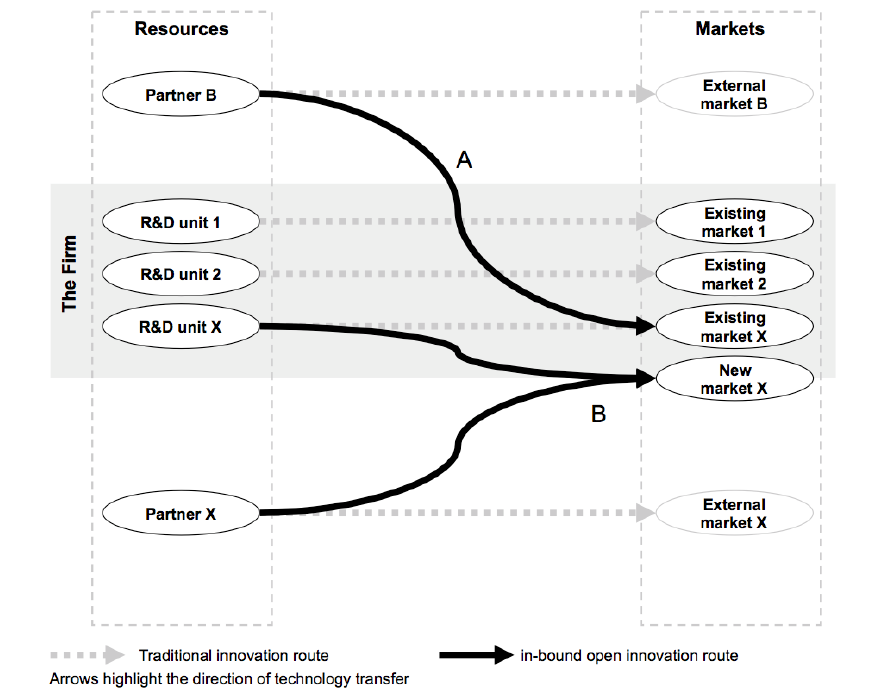
Fig. 2. In-bound open innovation (Mortara et al., 2011, p. 296) Out-bound OI relates to the exploitation of knowledge in a variety of ways. By revealing internal knowledge via out-bound OI, innovation finds its way towards commercialisation. 'Licensing-out', 'spin-off' and 'open-sourcing' are examples. As illustrated in Figure 3, internal resources can lead to the targeting of a new market. For example, licensing-out (curved line D in Figure 3) enables an external partner to use the firm's internal knowledge and create a new market (Mortara et al.,